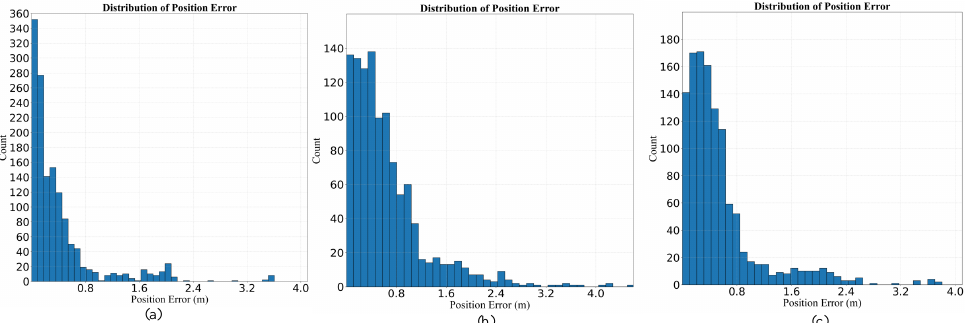
Figure 7. Error distribution of three methods in the aspect of position at dataset 19. ( a ) shows the estimation result of our PE-HL-PF, ( b ) denotes the result of PE-CPD, and ( c ) shows the result of